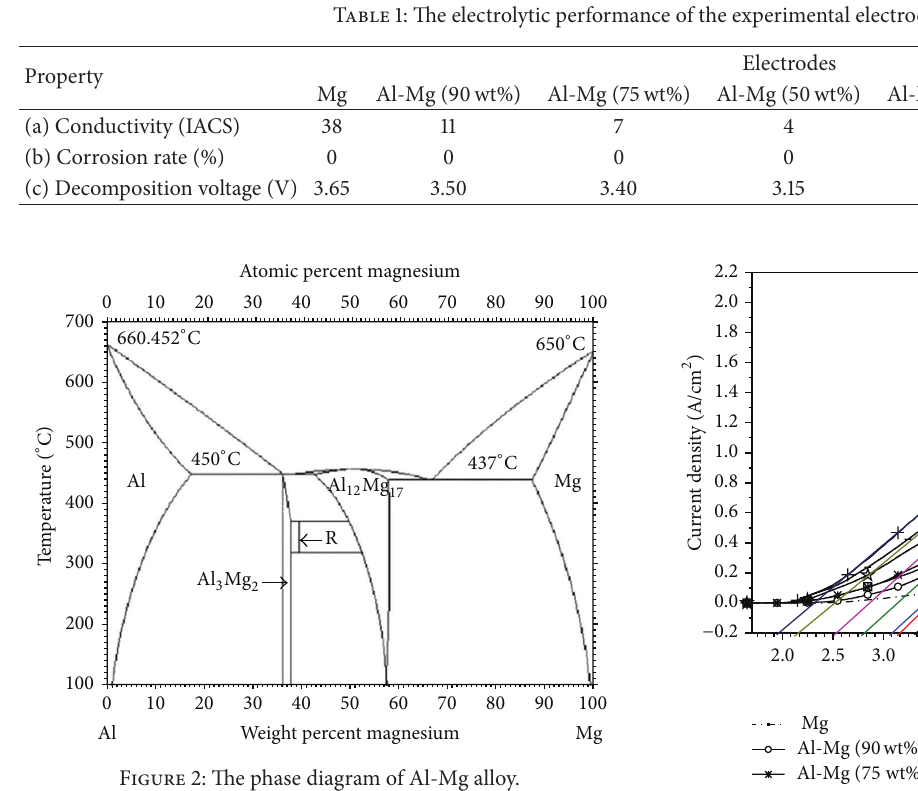
Figure 3: The I-V curve of seven electrodes in 30 wt% KOH